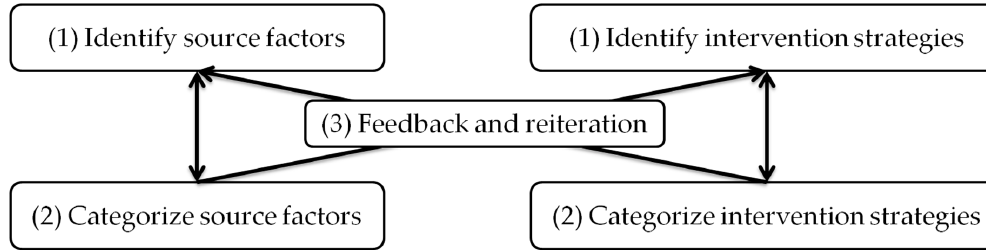
Figure 4. Three-step process model. Table 3. List of identified source factors (Step 1).